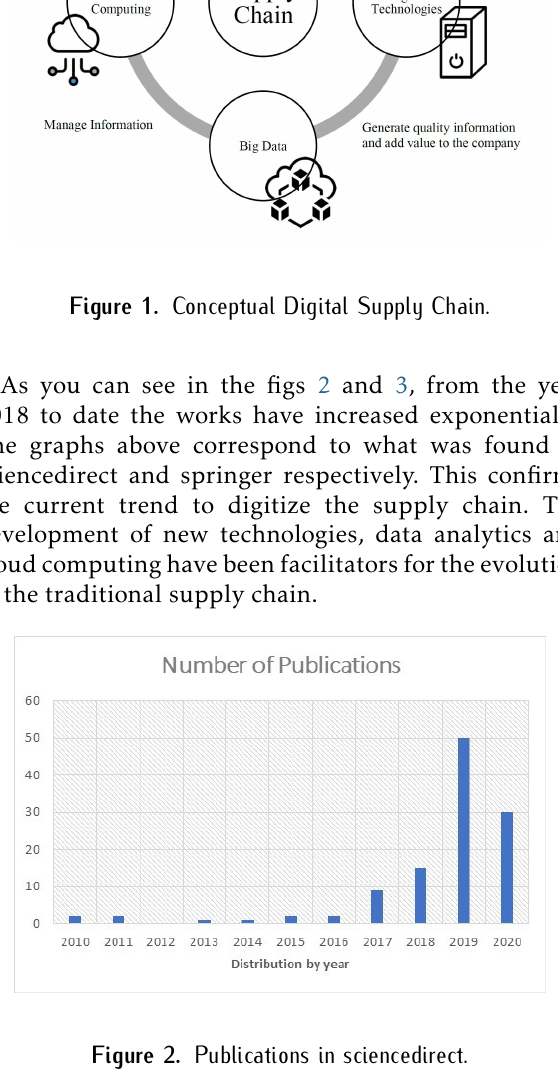
Figure 2. Publications in sciencedirect.